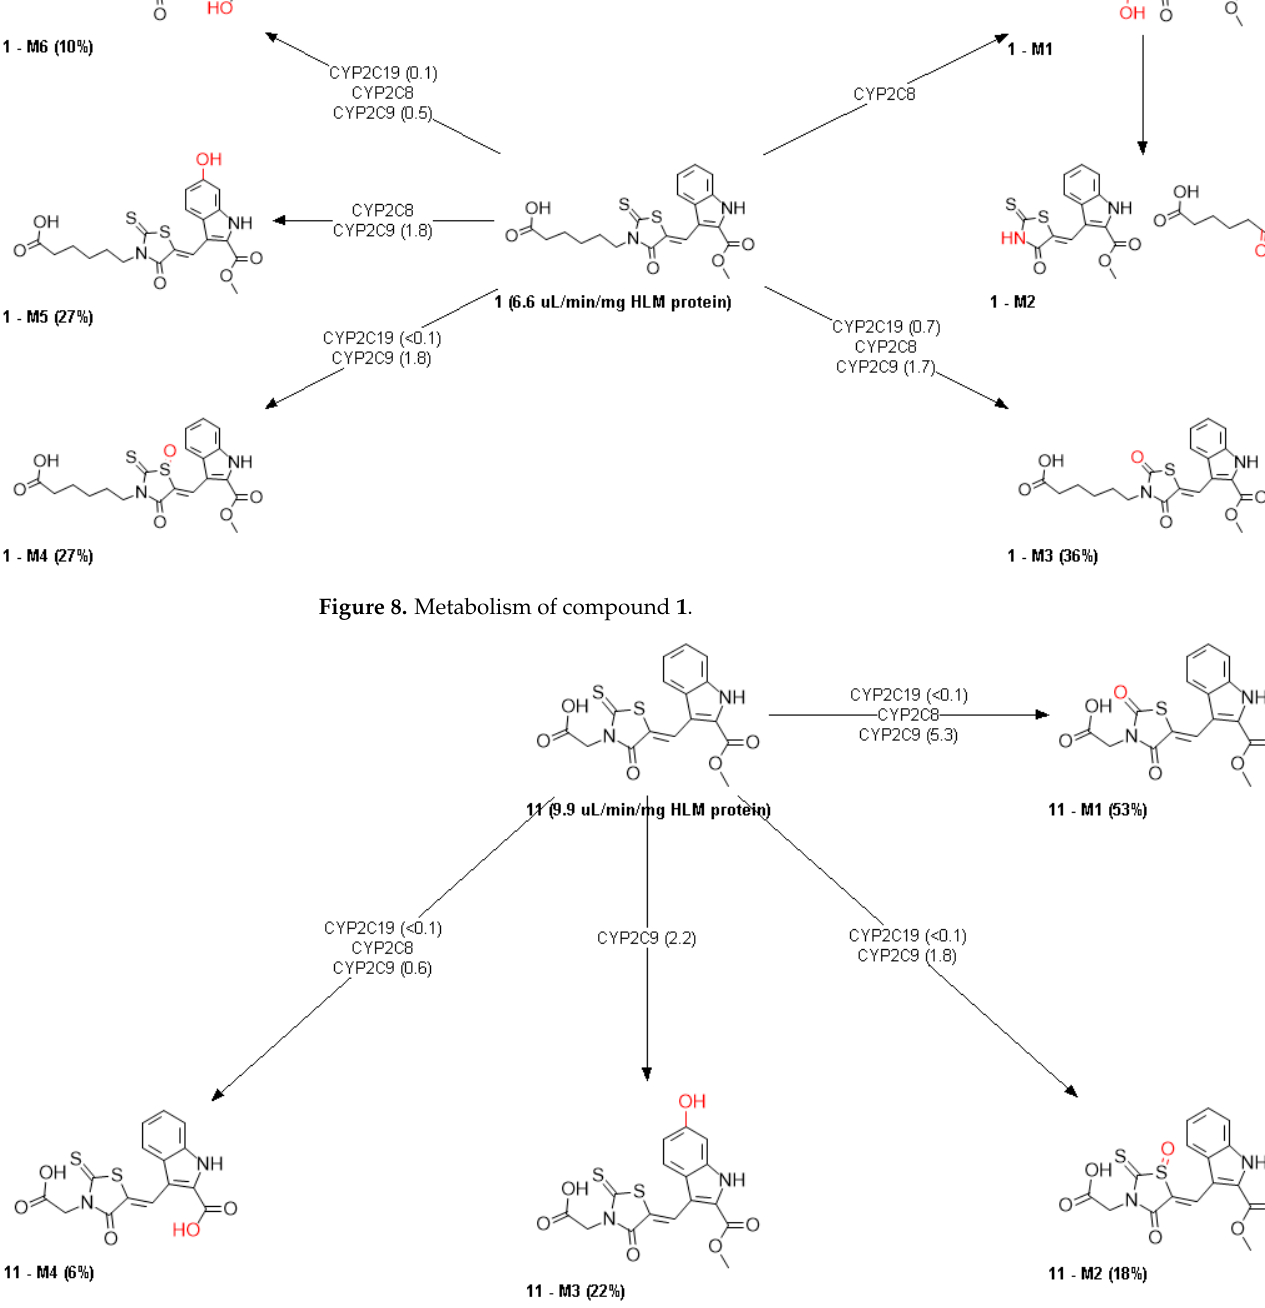
Figure 9. Metabolism of compound 11 .